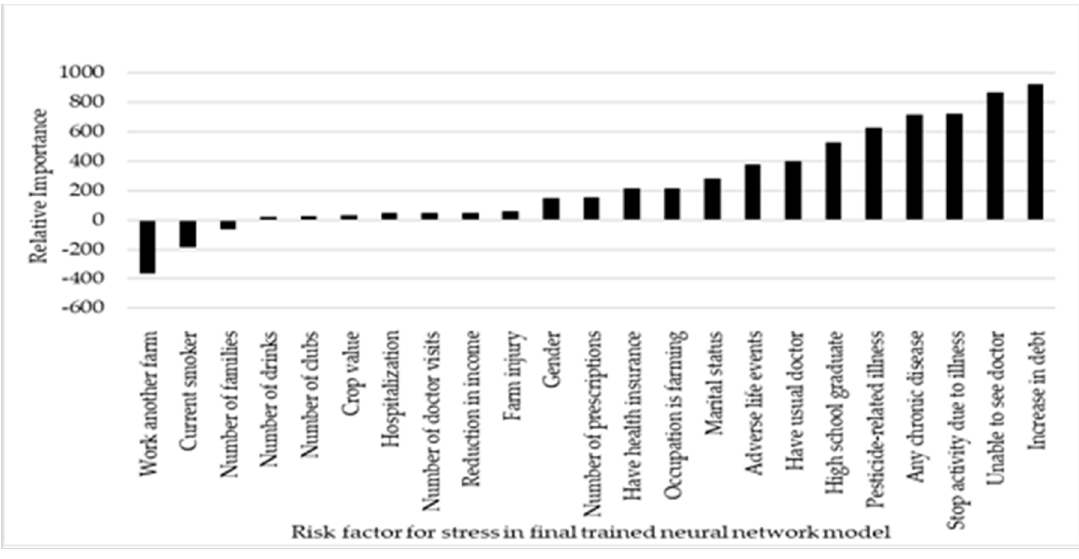
Figure 1. Relative importance of individual risk factors and covariates on increased stress in 1131 farm residents in Colorado from a neural network analysis, 1992–1997.